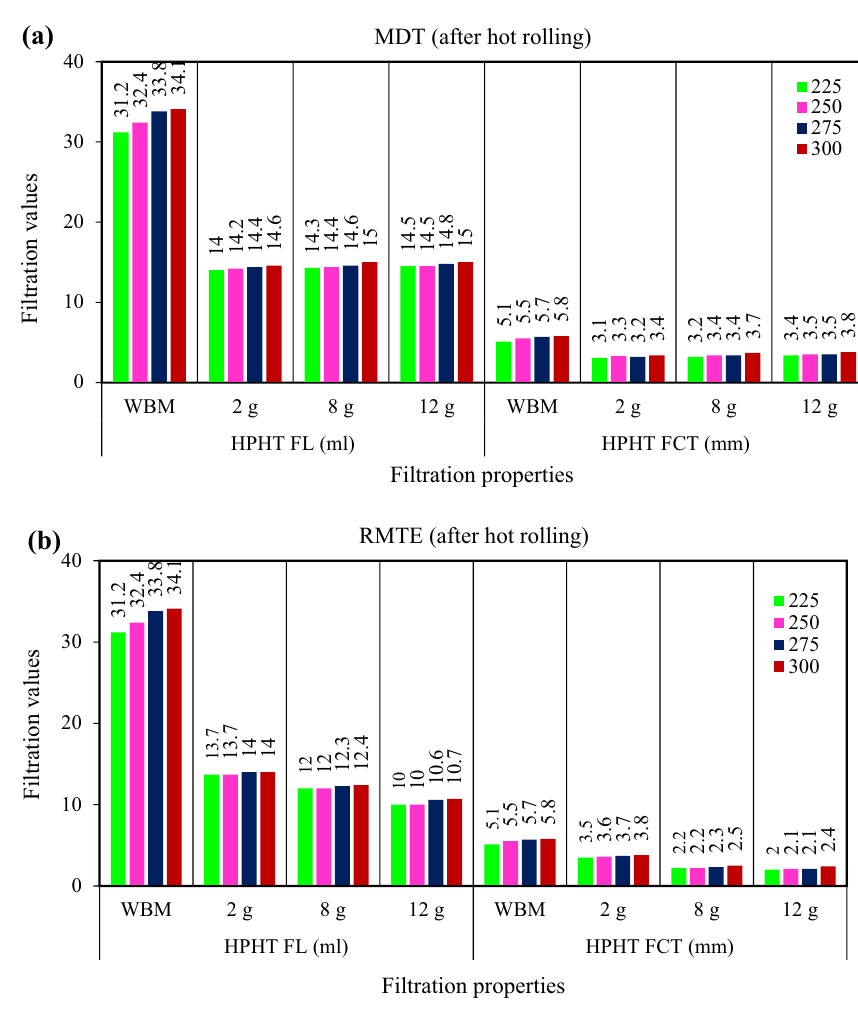
Fig. 14 HPHT filtration proper- ties of a MDT and b RMTE mud samples